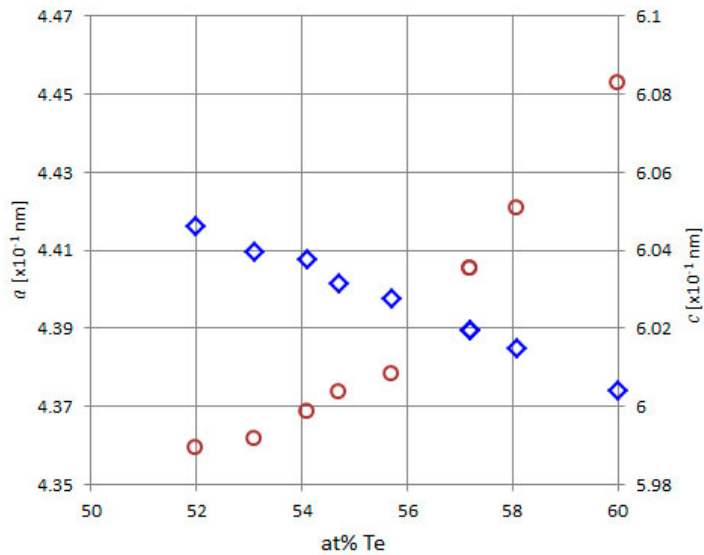
Figure 8. The fundamental lattice constants a (diamonds) and c (circles) as functions of the Te concentration in the Bi–Te binary system.